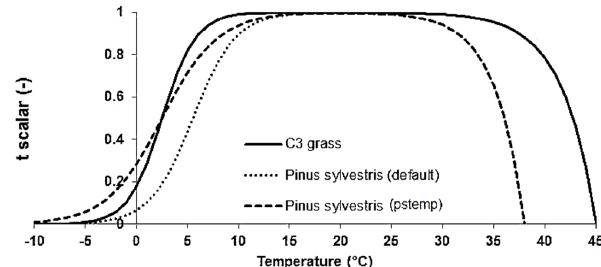
Figure 1. Temperature function ( t scalar ) for Pinus sylvestris and C 3 grass, values between 0 (photosynthesis maximally limited by temperature scalar) and 1 (photosynthesis not limited by tem- perature scalar). Default settings for P. sylvestris (dotted line: pstemp min = − 4 ◦ C, optimum 15–25 ◦ C, pstemp max = 37 ◦ C) and C 3 grass (solid line: pstemp min = − 5 ◦ C, optimum 10–35 ◦ C, pstemp max = 45 ◦ C). Changed parameterisation (pstemp) for P. sylvestris (pstemp min = − 10 ◦ C, optimum 15–25 ◦ C, pstemp max = 37 ◦